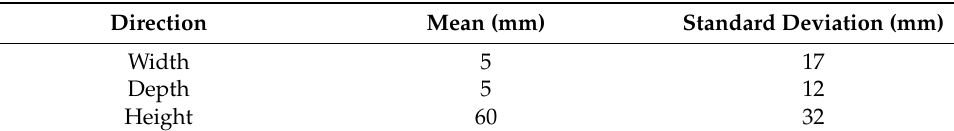
Table 6. Mean and standard deviation of the positioning error of the end-effector center with respect to the stalk center.